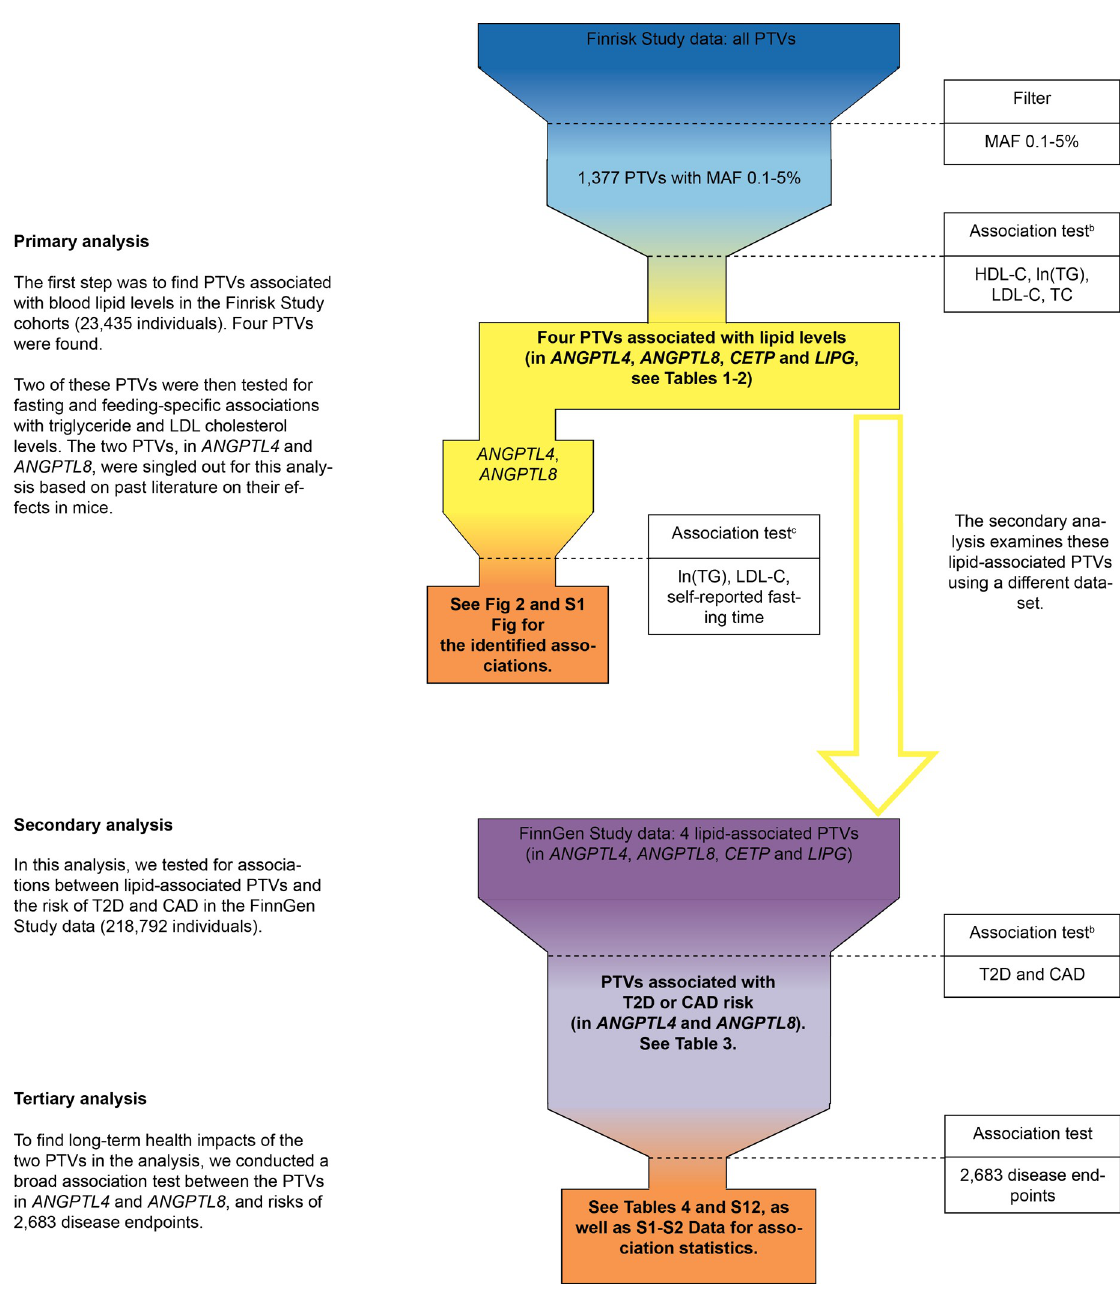
Fig 1. An overview of the present study. a Abbreviations: PTV, protein-truncating variant; MAF, minor-allele frequency; HDL-C, high- density lipoprotein cholesterol level; ln(TG), natural logarithm of triglyceride level; LDL-C, low-density lipoprotein cholesterol level; TC, total cholesterol level; T2D, type 2 diabetes; CAD, coronary artery disease. a Shown in the figure is an overview of the present study. The final results are shown in boxes with a bolded font. b Results for these association tests were also compared with other PTVs in UK Biobank. c These association tests were post-hoc in